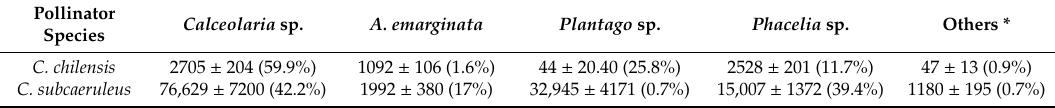
Table 1. Pollen load composition of the two oil-collecting bees under study.